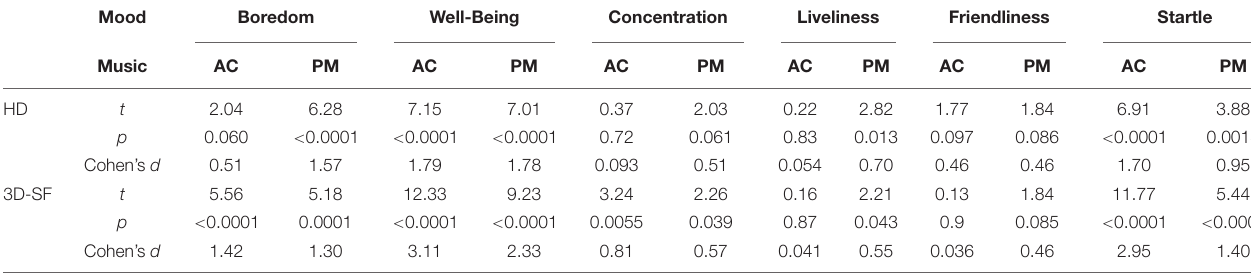
TABLE 1 | Summary of comparison of each mood between, before, and after listening to music. Mood Boredom Well-Being Concentration Liveliness Friendliness Startle